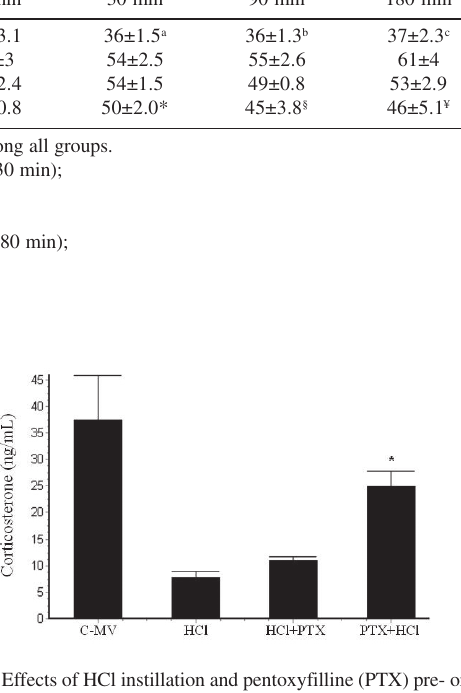
Figure 2 - Effects of HCl instillation and pentoxyfilline (PTX) pre- or post- treatments on corticosterone levels in BAL from rats under mechanical ventilation. * p <0.05 versus the HCl and the HCl+PTX groups. Values are presented as mean ± SD.